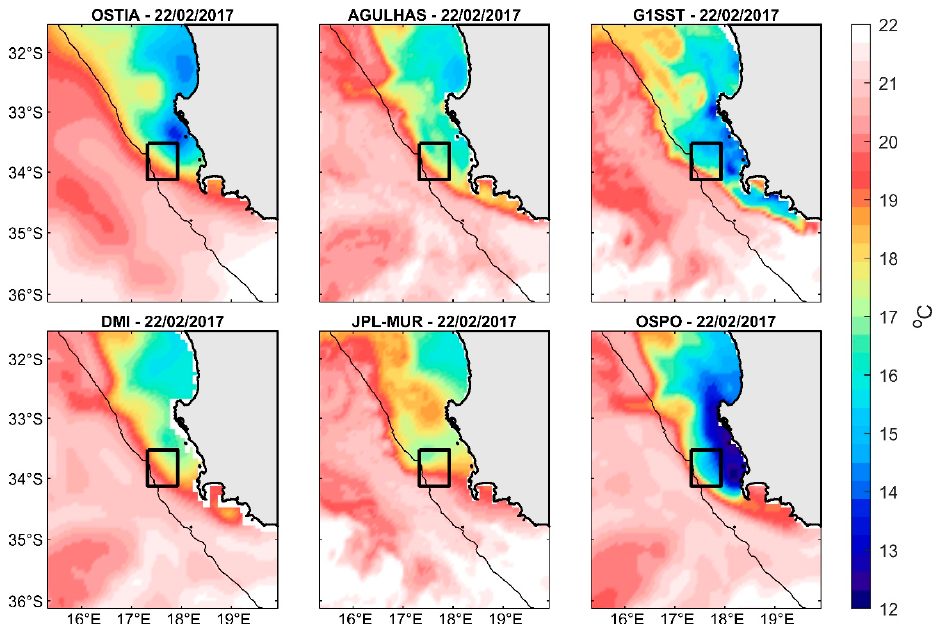
Figure 6. A daily snapshot for each L4, high resolution SST product for the 12 January 2017 in the northern Benguela. The thin black contour shows the 1000 m isobath. The black square shows the box referred to as the Lüderitz region where the highest SST variance was observed. Remote Sens. 2020 , 12 , x FOR PEER REVIEW